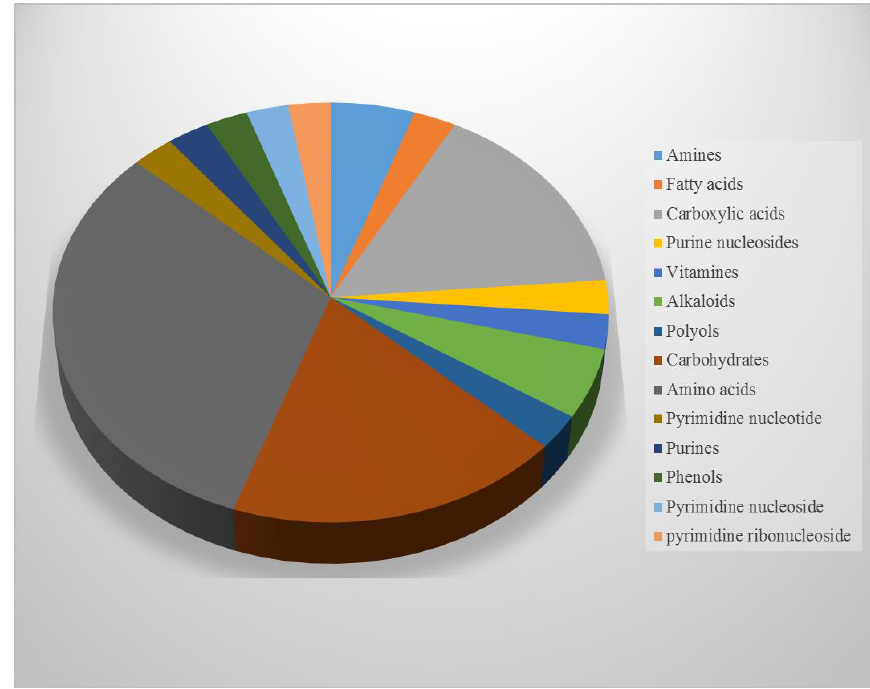
Figure 4. The percentage of chemical classes identified in the polar extract of Subramaniula asteroids .